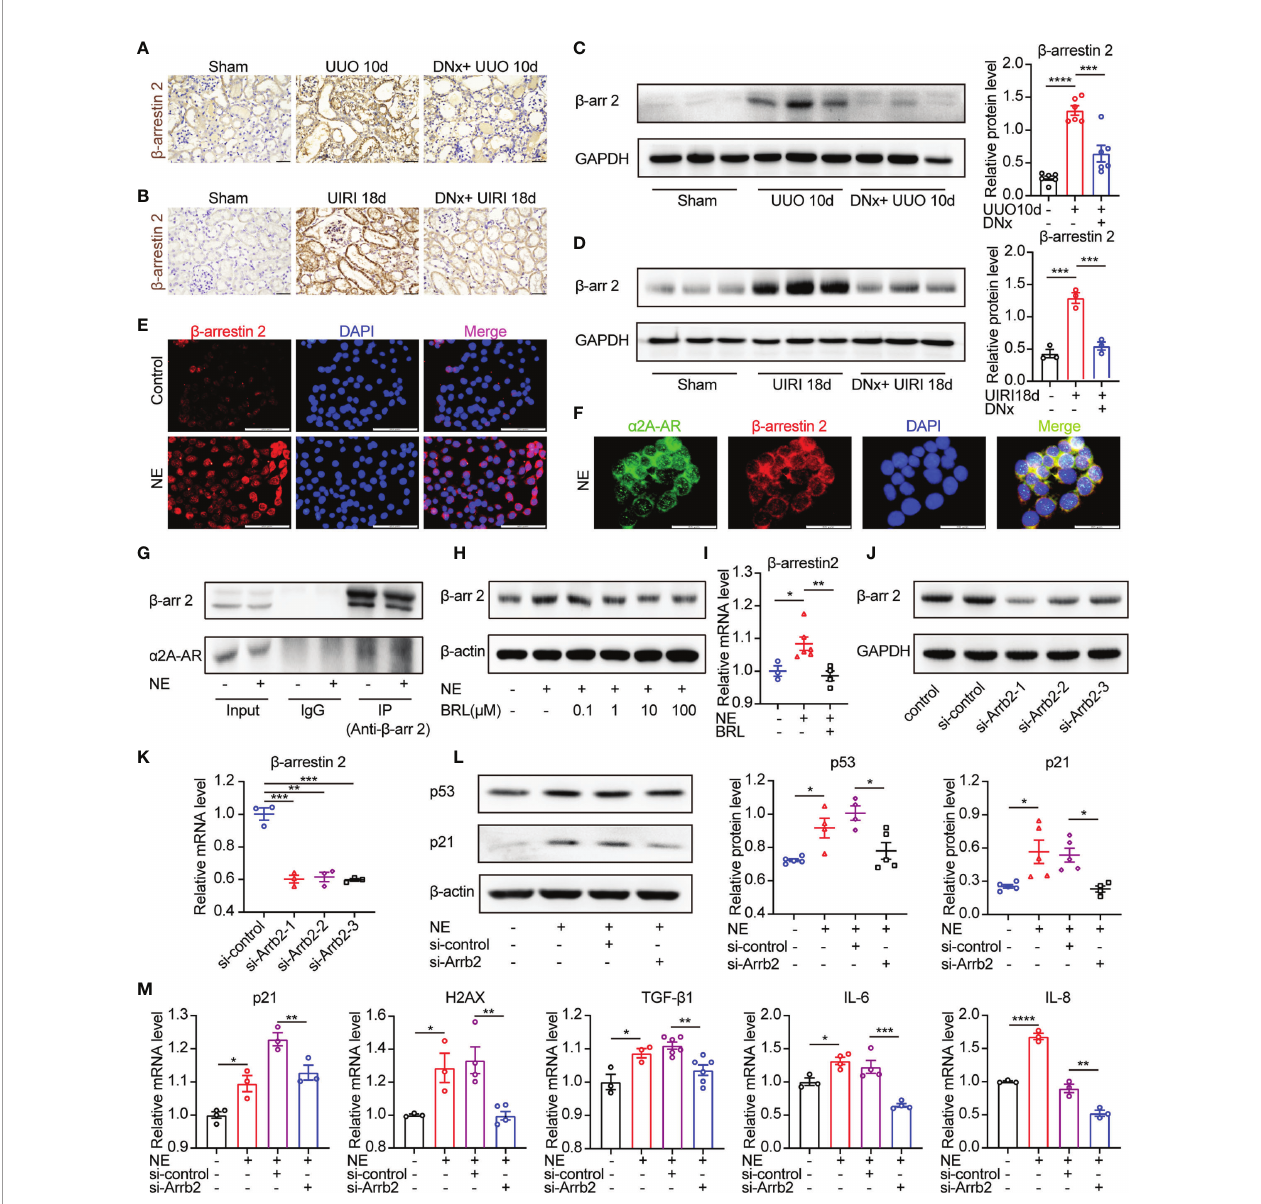
FIGURE 6 | b -arrestin2 is a target of a 2A -AR and knockdown of b -arrestin2 ameliorates NE-induced tubular cellular senescence. (A, B) Renal denervation (DNx) or sham operation was performed 2 days before UUO or UIRI in the left kidneys of mice. Representative images of immunohistochemistry for b -arrestin2 in sham-operated, UUO/UIRI mice, and DNx+UUO/UIRI mice. Scale bar, 20 m m. (C, D) Representative Western blotting of b -arrestin2 ( b -arr2) in sham-operated, UUO/UIRI, and DNx+UUO/UIRI kidneys with densitometry analysis (n=3 – 6 in each group). (E – G) TKPTS cells were cultured with PBS or NE (10 nM) for 48 hours. (E) Representative images of immuno fl uorescence for b -arrestin2 in each group. Scale bar, 20 m m. (F) Cells were double-labeled with a 2A -AR (green) and b -arrestin2 (red), and cell nuclei were enhanced by staining with DAPI (blue). Colocalization of a 2A -AR (green), and b -arrestin2 (red) was visualized as yellow in merged images. Scale bar, 20 m m. (G) Interactions between b -arrestin2 and a 2A -AR were examined by immunoprecipitation (IP) with an anti- b -arrestin2 antibody, followed by immunoblotting (IB) with anti- a 2A -AR antibodies. (H, I) After an hour of pretreatment with PBS or BRL4408, TKPTS cells were stimulated with NE (10 nM) for 48 hours. (H) Representative Western blotting of b -arrestin2 ( b -arr2) in TKPTS cells treated with PBS, NE, and NE +BRL (100 nM, 1 m M, 10 m M, and 100 m M) (n=3 in each group). (I) mRNA expression of b -arrestin2 in PBS, NE, and NE+BRL (10 m M)-treated TKPTS cells as measured by qRT-PCR analysis (n=3 – 6 in each group). (J, K) TKPTS cells were transfected with scrambled siRNA or three b -arrestin2 siRNAs (si-Arrb2- 1, si-Arrb2-2, or si-Arrb2-3) for 48 hours. b -arrestin2 ( b -arr2) expression was examined by Western blot analysis (J) and qRT-PCR analysis (K) (n=3 in each group). (L, M) TKPTS cells were transfected with scrambled siRNA (si-control) or b -arrestin2 siRNA (si-Arrb2) 24 hours before NE (10 nM) treatment. Representative Western blotting of p53 and p21 in each group with densitometry analysis (L) (n=4 – 5 in each group). mRNA expressions of p21, H2AX, TGF- b 1, IL-6, and IL-8 were tested by qRT-PCR analysis (M) (n=3 – 6 in each group). *P < 0.05, **P < 0.01, ***P < 0.001, ****P < 0.0001. Bars represented means ±